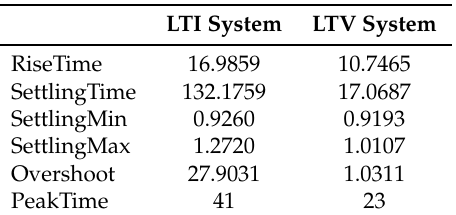
Table 4. Comparison of the linear time-invariant (LTI) and time-varying (LTV) systems.